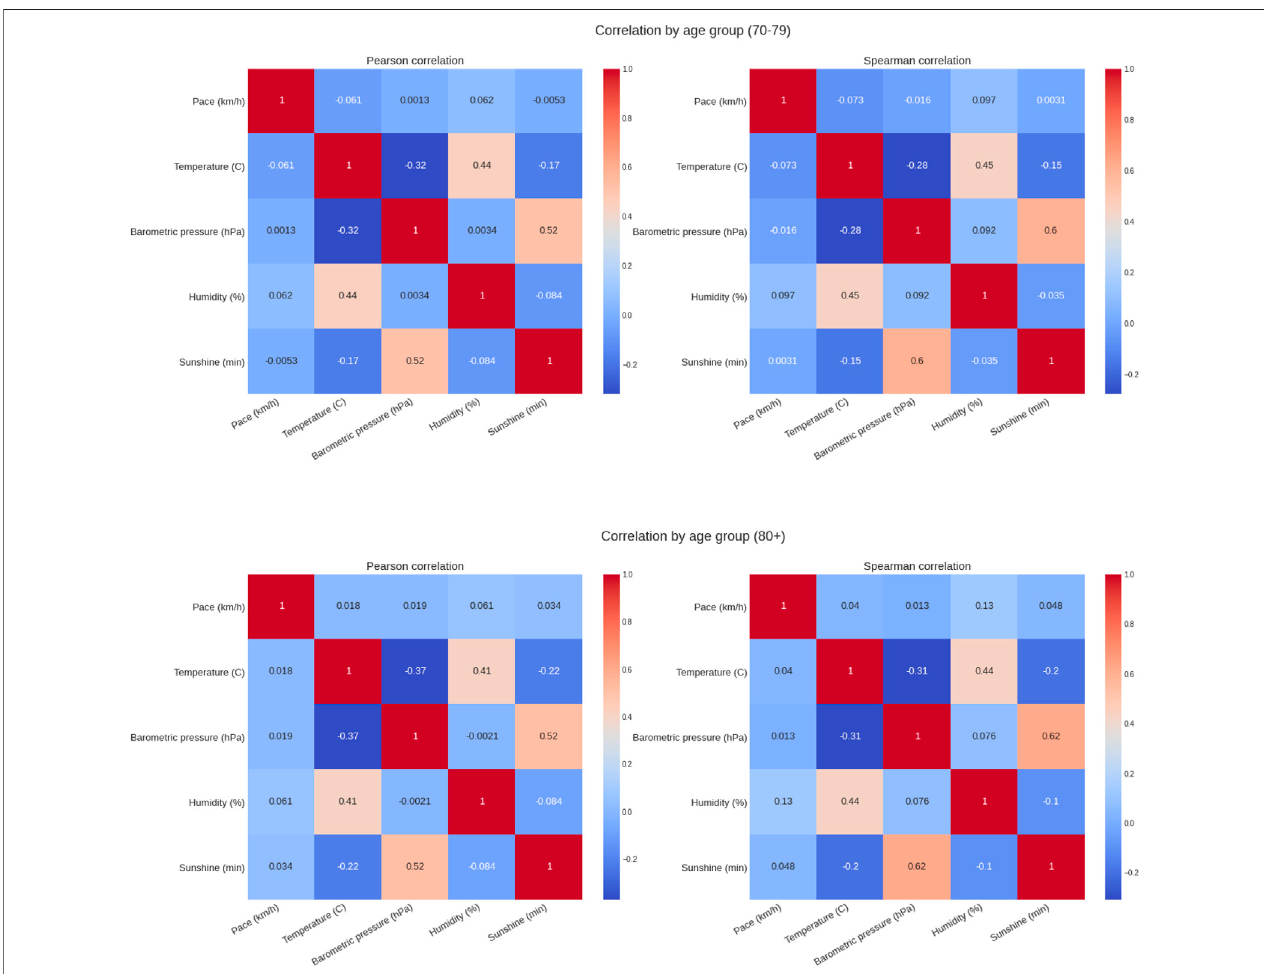
FIGURE 10 | Correlation analyses using time-adjusted average of weather conditions by age groups